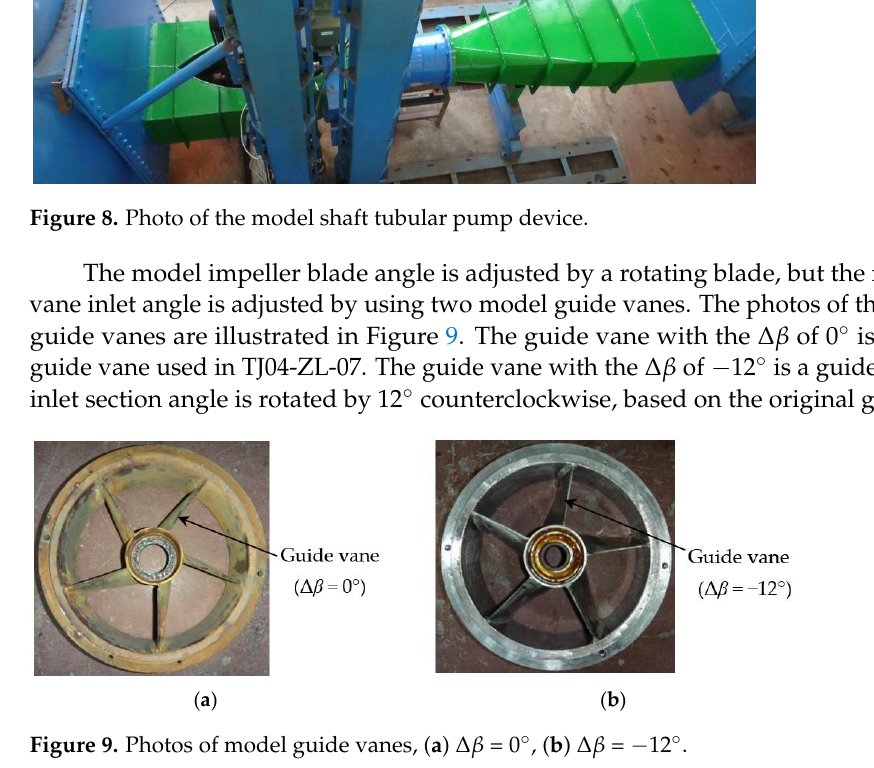
Figure 9. Photos of model guide vanes, ( a )  = 0°, ( b )  = −12° .